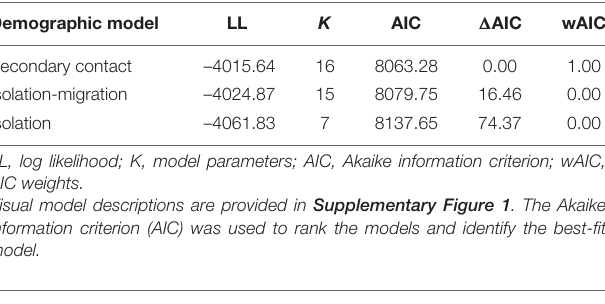
TABLE 3 | Demographic parameter estimates for Phrynosoma hernandesi populations (north, west, south) under the secondary contact model.